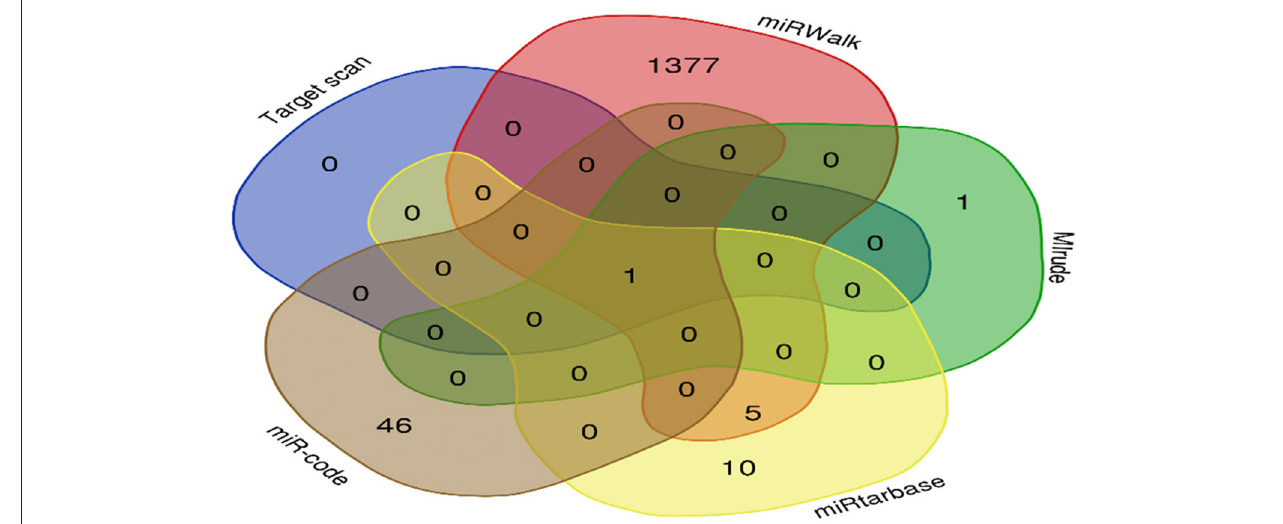
FIGURE 4 | SERPINA3 target gene prediction. The five datasets had one overlapping microRNA, miR-137.